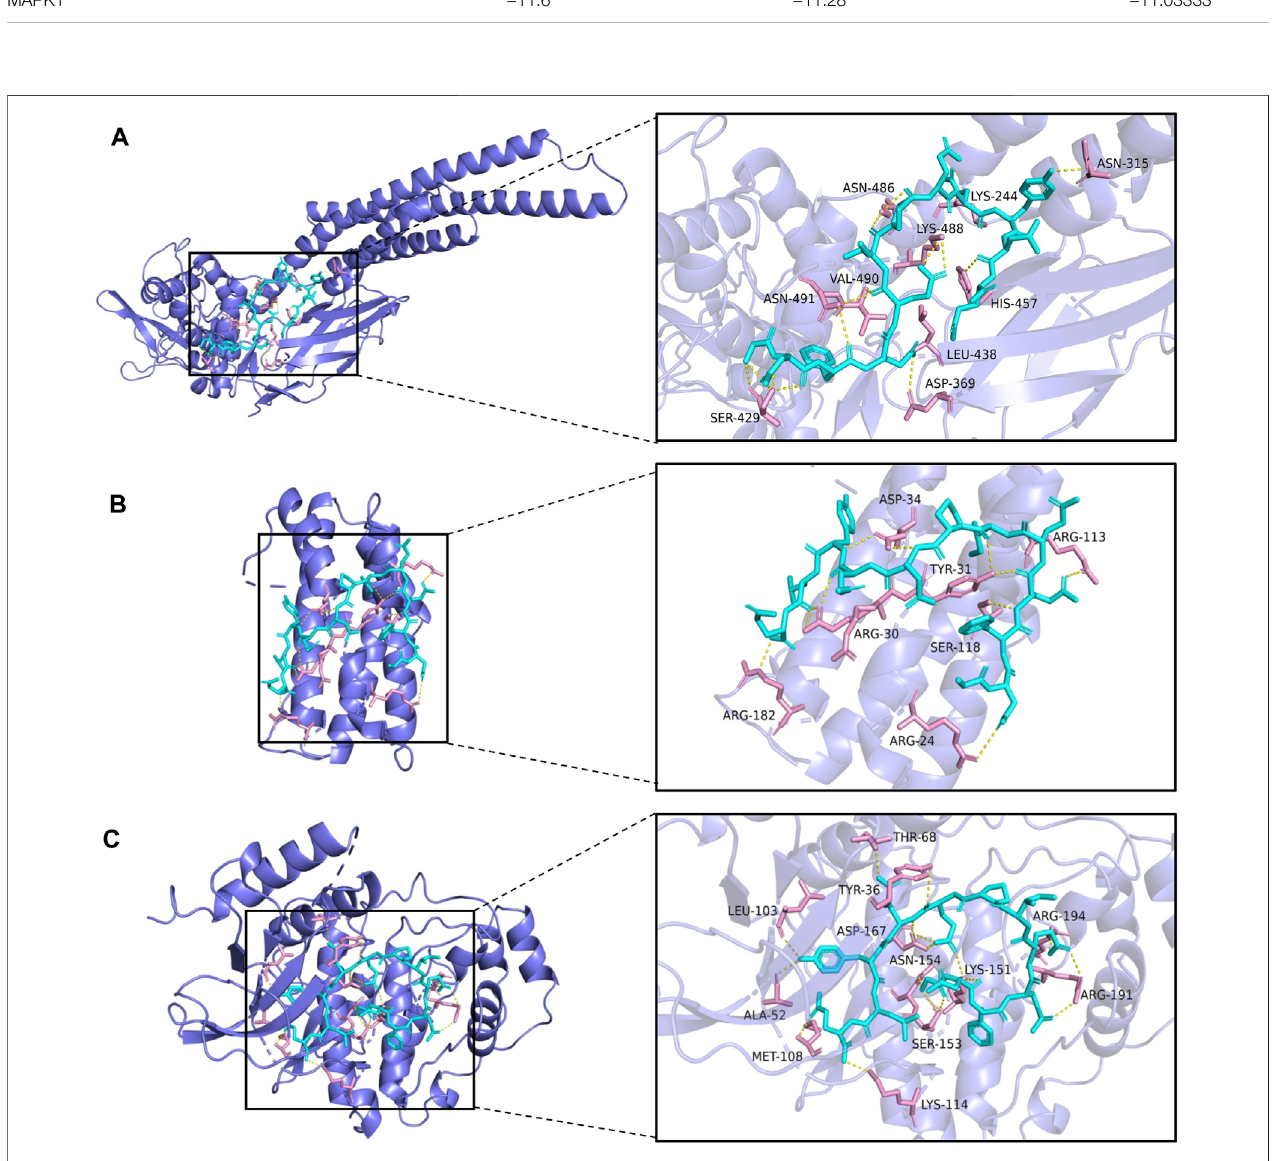
FIGURE 5 | The top 3 binding energy molecular docking models. (A) Hirudin and STAT3. (B) Hirudin and IL-6. (C) Hirudin and MAPK1.